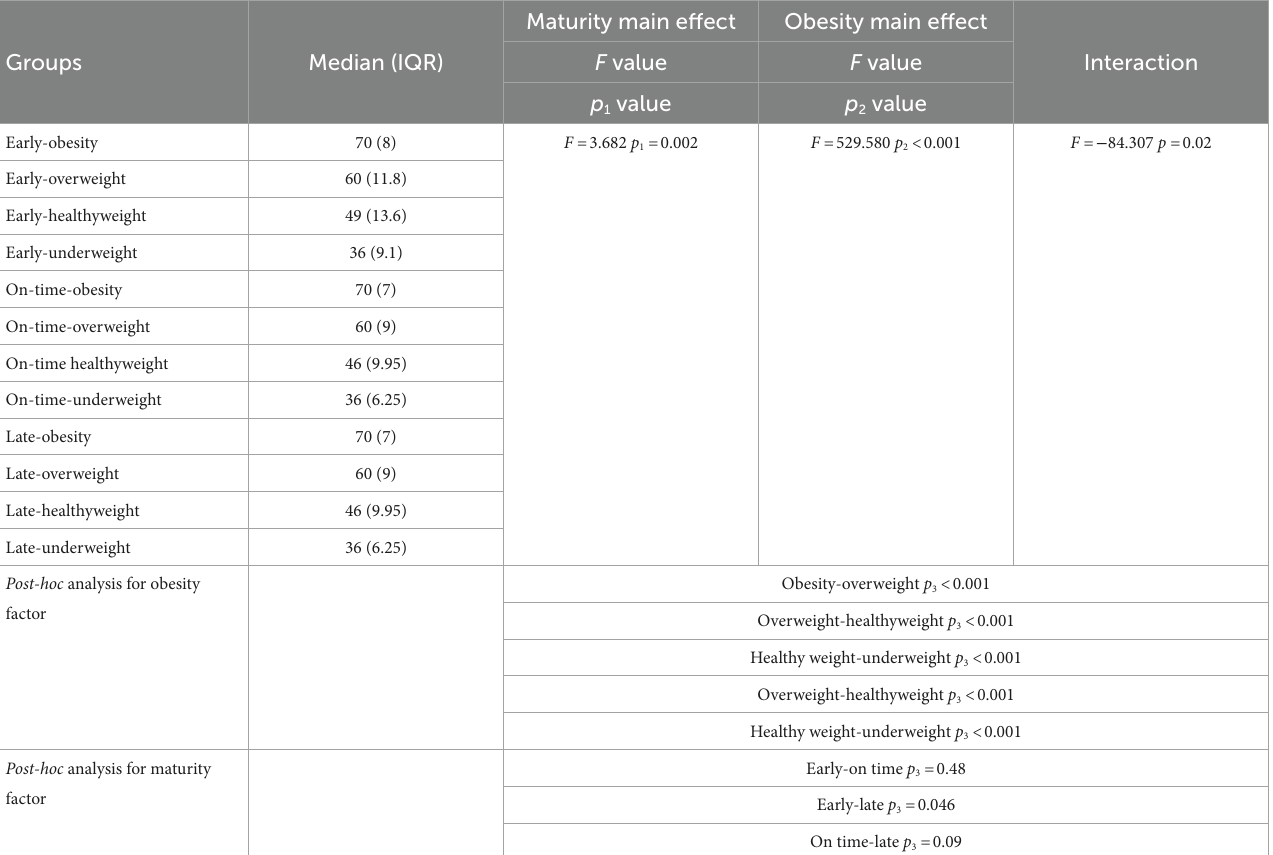
TABLE 2 Changes in the body weight of the participants according to the maturity and obesity